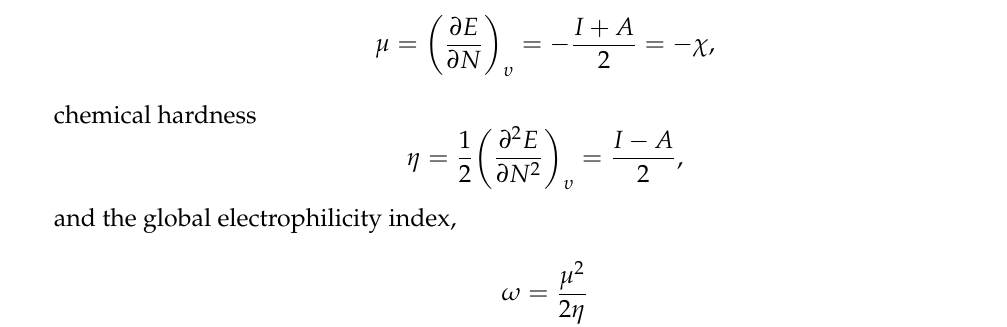
Figure 7. Isosurface plots of the ( a ) s orbitals of the S-H bond, and of the lone pairs ( b ) η 1 (S) and ( c ) η 2 (S) of the S atom in glutathione, calculated at the M06-2X/6-311++G(d,p) level of theory. From the energies of the HOMO and LUMO, the chemical reactivity descriptors of the GSH were determined as the potential chemical,